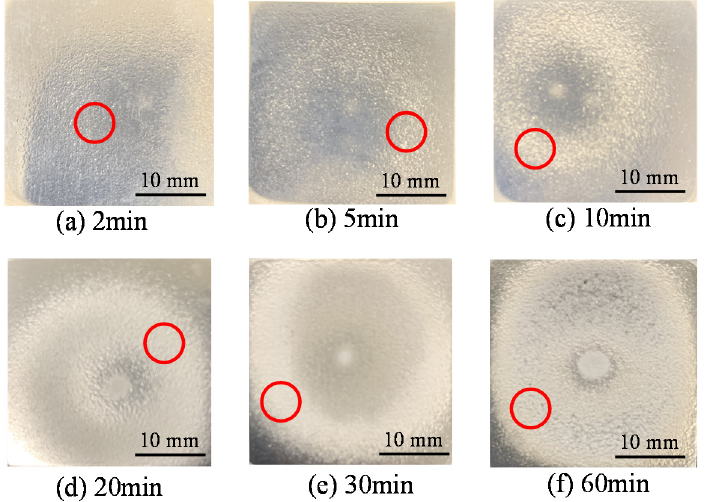
Figure 4. Surface photographs after UPTC processing (alloy: AC4CH, jet: 35 MPa, UC: 800 W). ( ○: roughness and hardness measurement area).